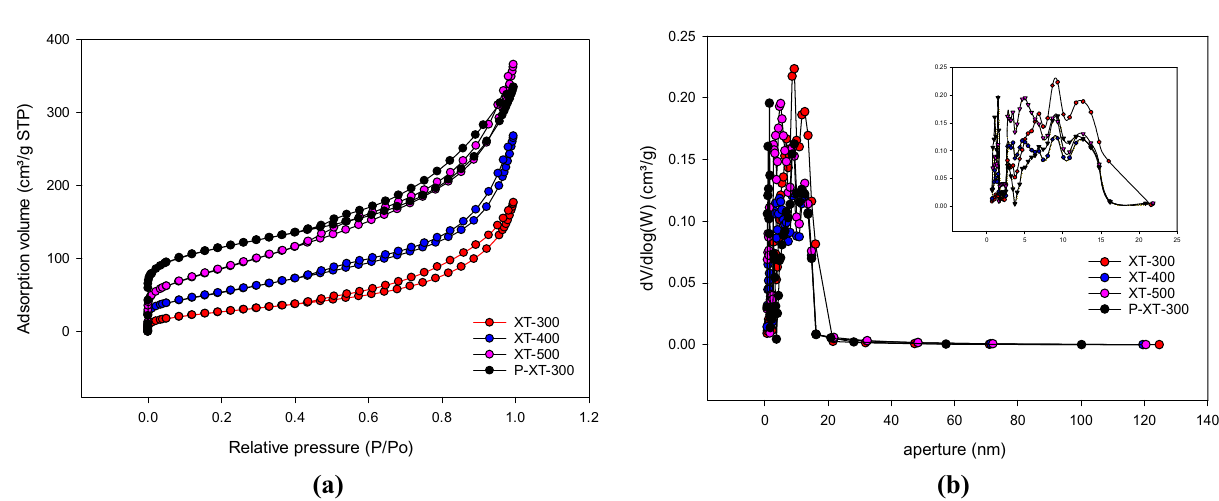
Figure 7. BET analysis of adsorbents at different temperatures ( a ) N 2 adsorption/desorption isotherm, ( b ) Pore size